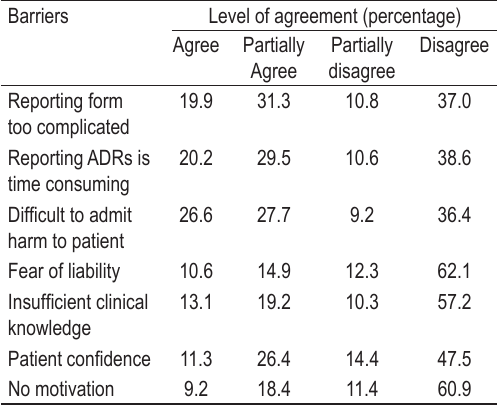
Table 2. Barriers to spontaneous reporting of ADRs